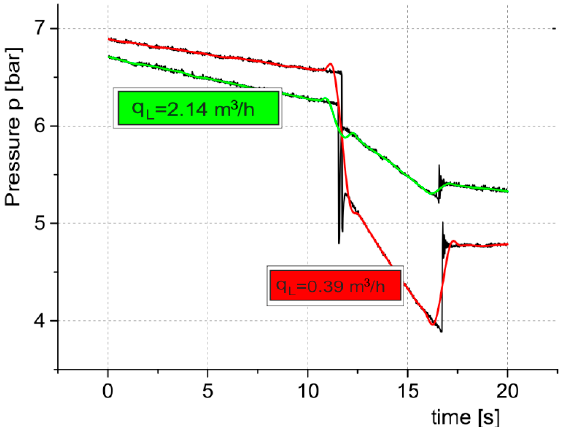
Figure 10. Graphical representation of the pressure p ( t ) measurement results with and without digital filtering.